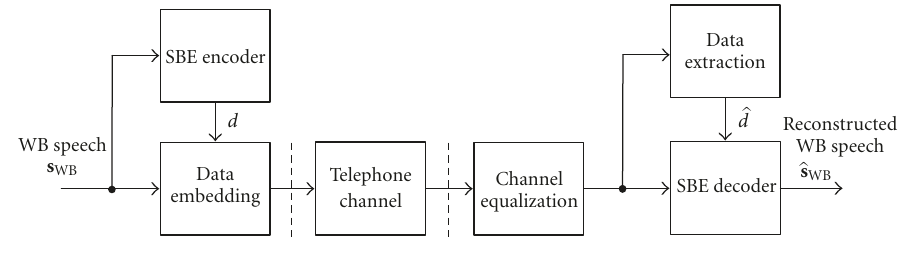
Figure 1: Speech bandwidth extension (SBE) system